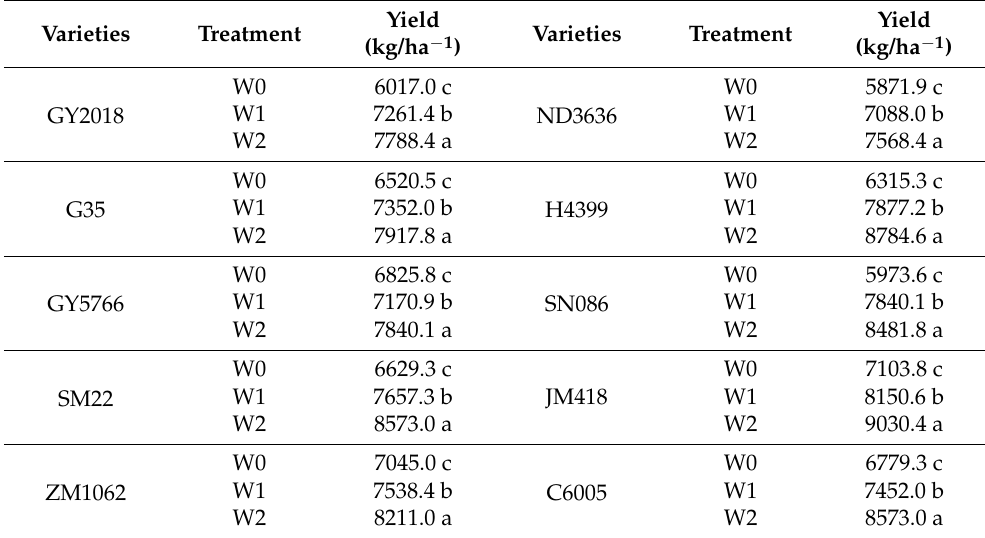
Table 3. The yield of different varieties under different deficit irrigation